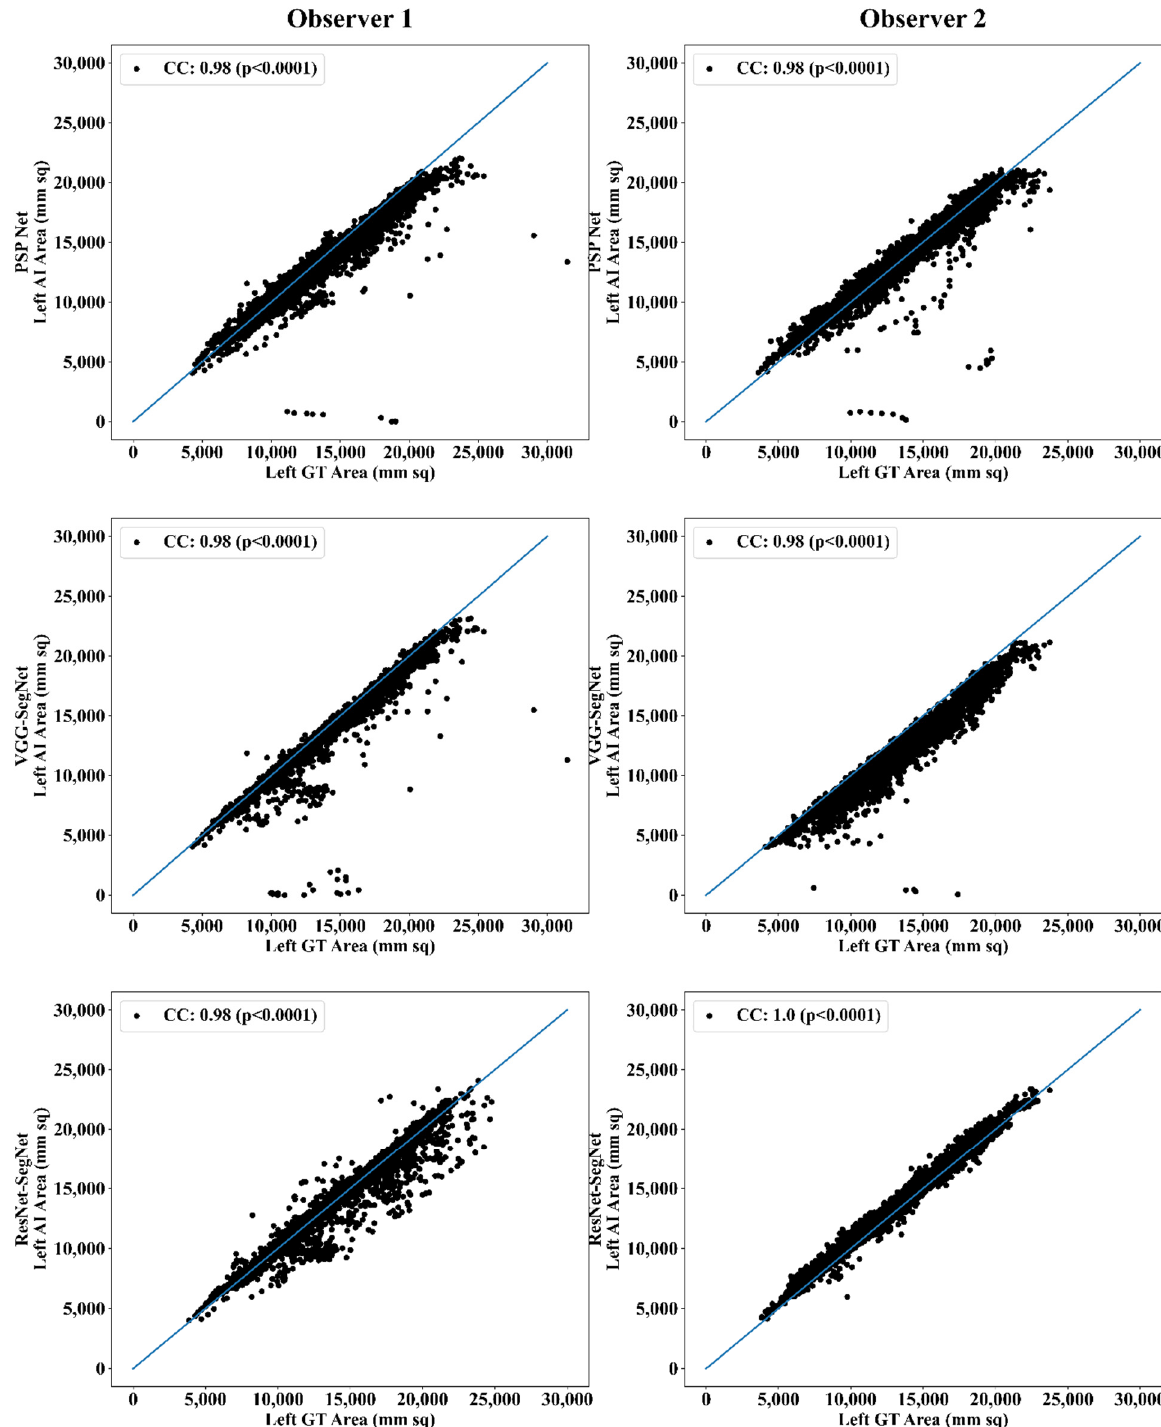
Figure 14. CC of left lung area using three AI models: Observer 1 vs. Observer 2.